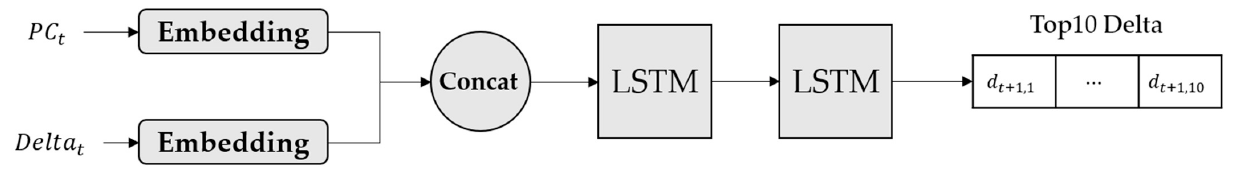
Figure 11. The Embedding LSTM Model [14].